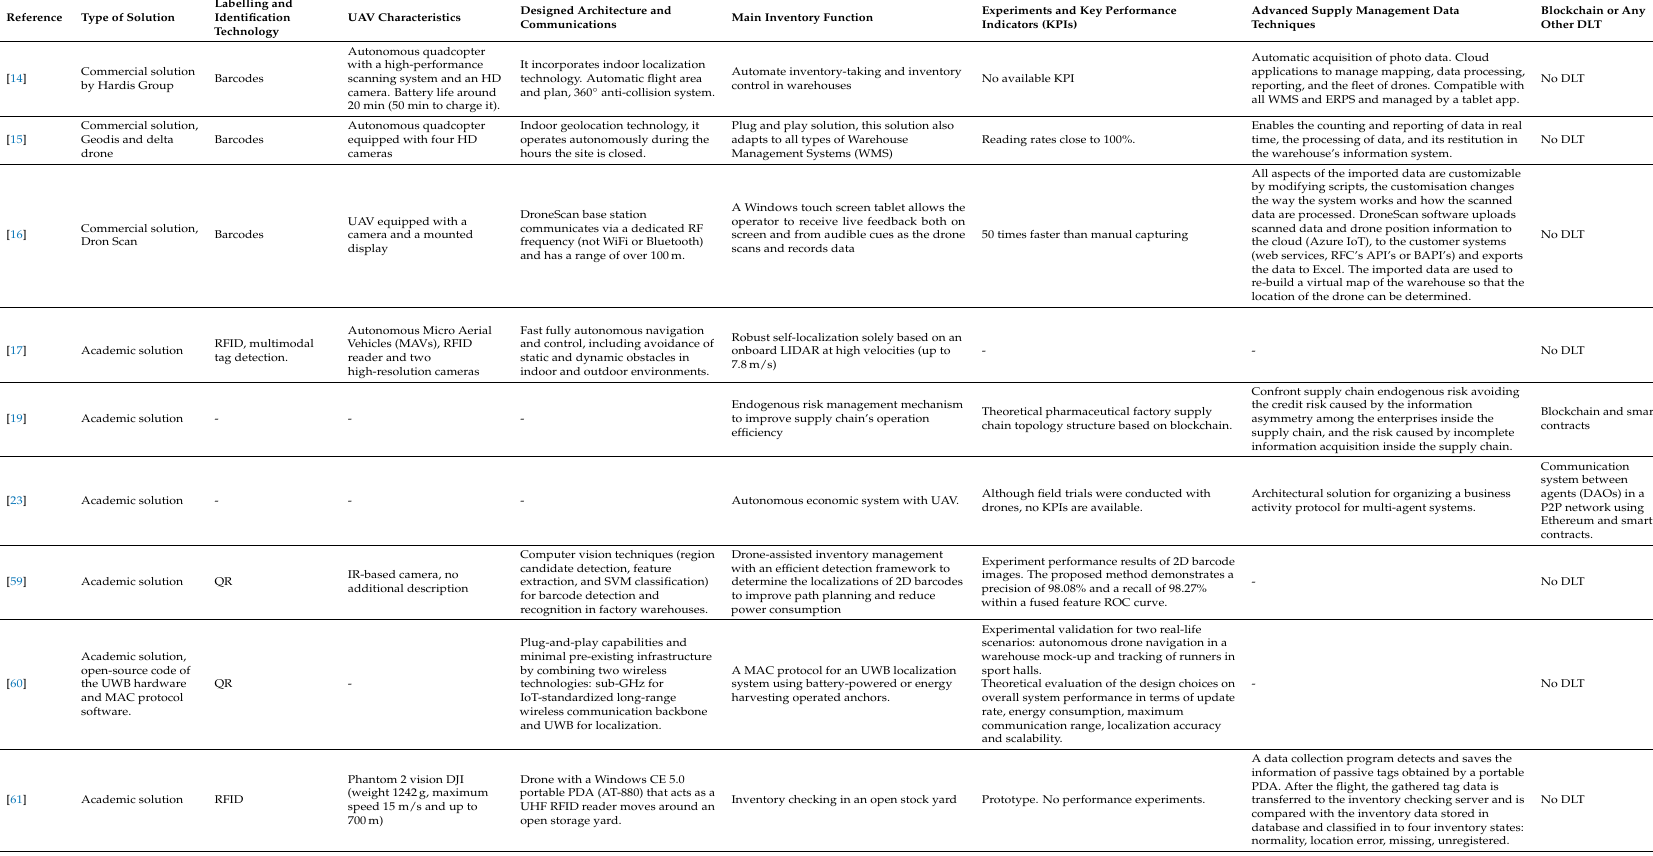
Table 2. Comparison of the main features of the most relevant UAV-based inventory systems and the proposed